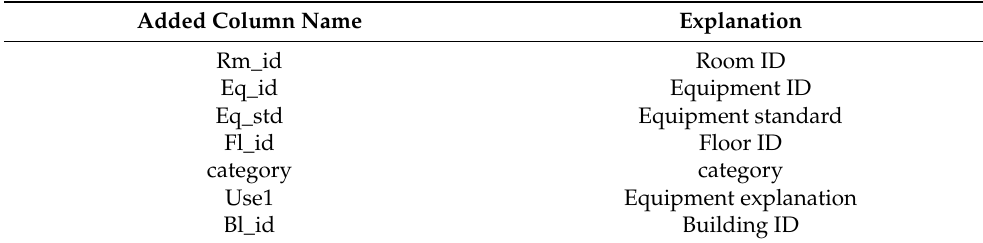
Table 1. Table 1. Spatial column data used in this